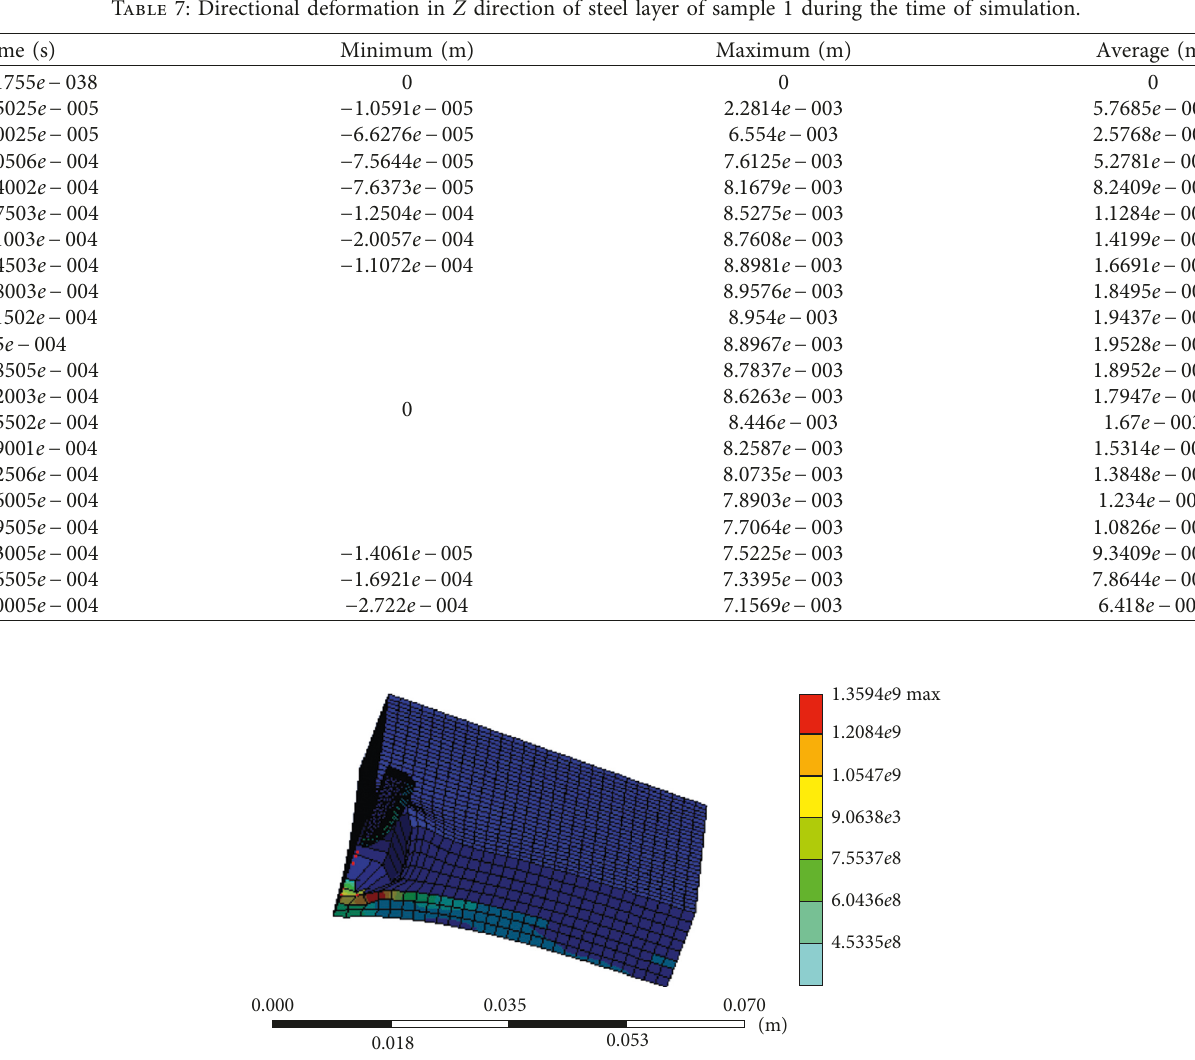
Figure 8: 3D cross section of sample 1 shows the residual stress in both the sample and the